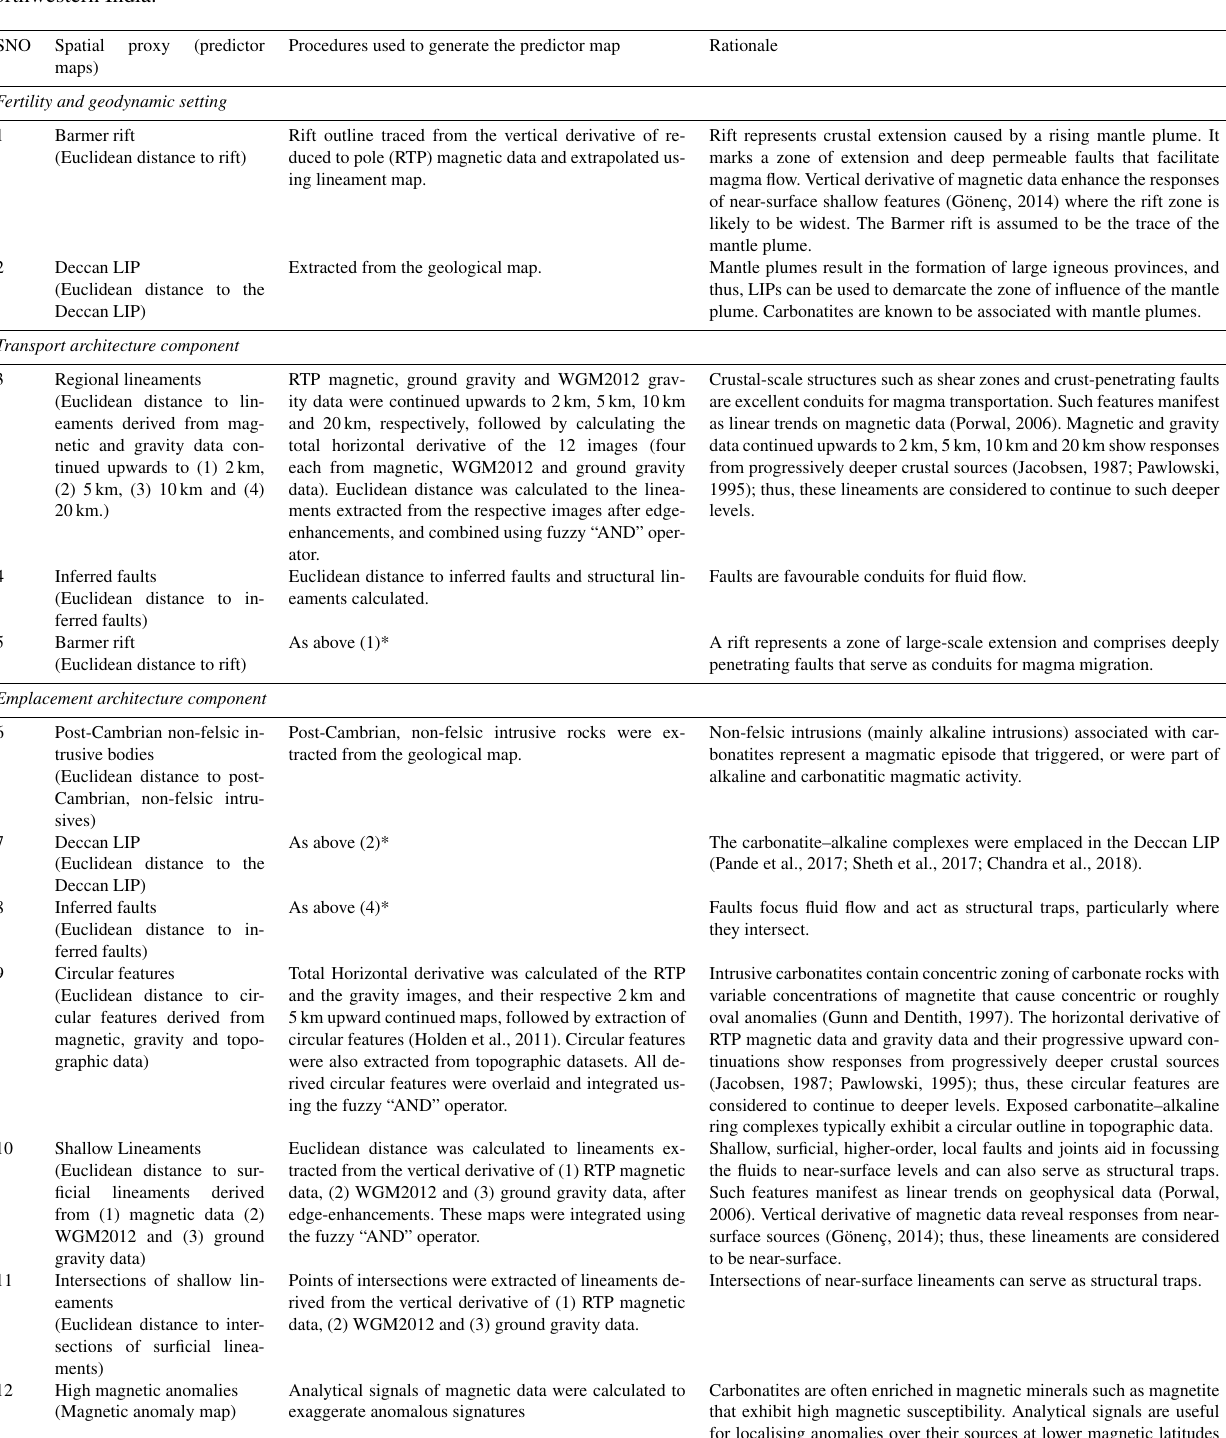
Table 3. Targeting model, spatial proxies and steps used to derive the predictor maps of the three components of the REE mineral system in northwestern